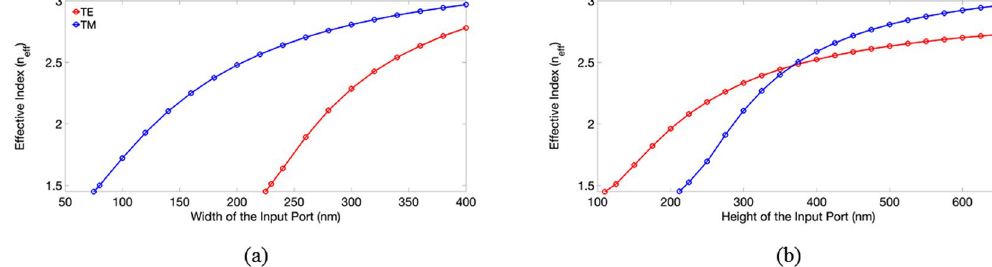
Figure 3. The calculated effective indices of TE and TM modes versus ( a ) the width at the height of 625 nm and ( b ) the height at the width of 380 nm of the input port.